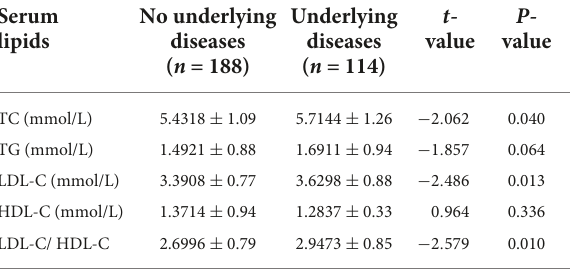
TABLE 2 Concentrations of lipids (mmol/L) and LDL-C/ HDL-C ratio in the two